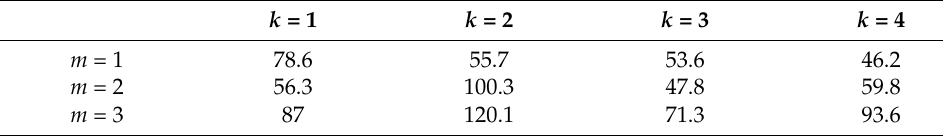
Table 10. Linear distance of DD km.